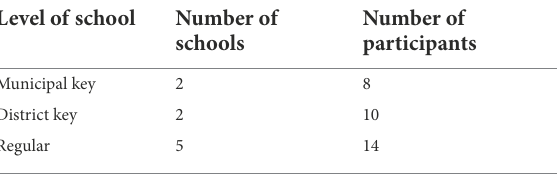
TABLE 1 Number of participants from the nine schools. Level of